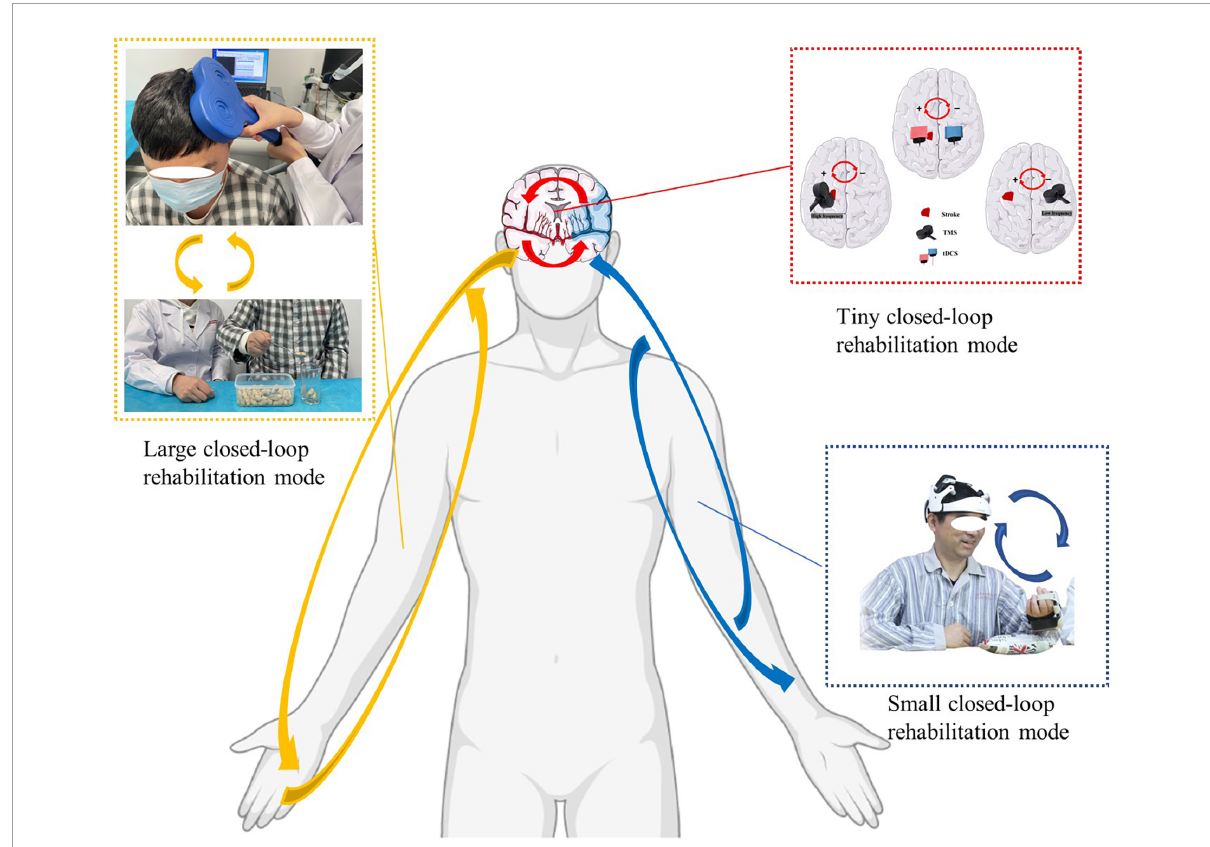
FIGURE2 Closed-loop rehabilitation modes: large closed-loop rehabilitation mode, small closed-loop rehabilitation mode, and tiny closed-loop rehabilitation mode (The written informed consent was obtained from the individual for the publication of the image). Red arrow: tiny closed-loop rehabilitation mode, the modulation effect in the intra-hemisphere or the inter-hemisphere. Blue arrow: small closed-loop rehabilitation mode, an intervention strategy that relies on independent, comprehensive intervention that does not combine with peripheral interventions. Yellow arrow: large closed-loop rehabilitation mode, the different combinations of central intervention techniques combined with peripheral intervention technique.